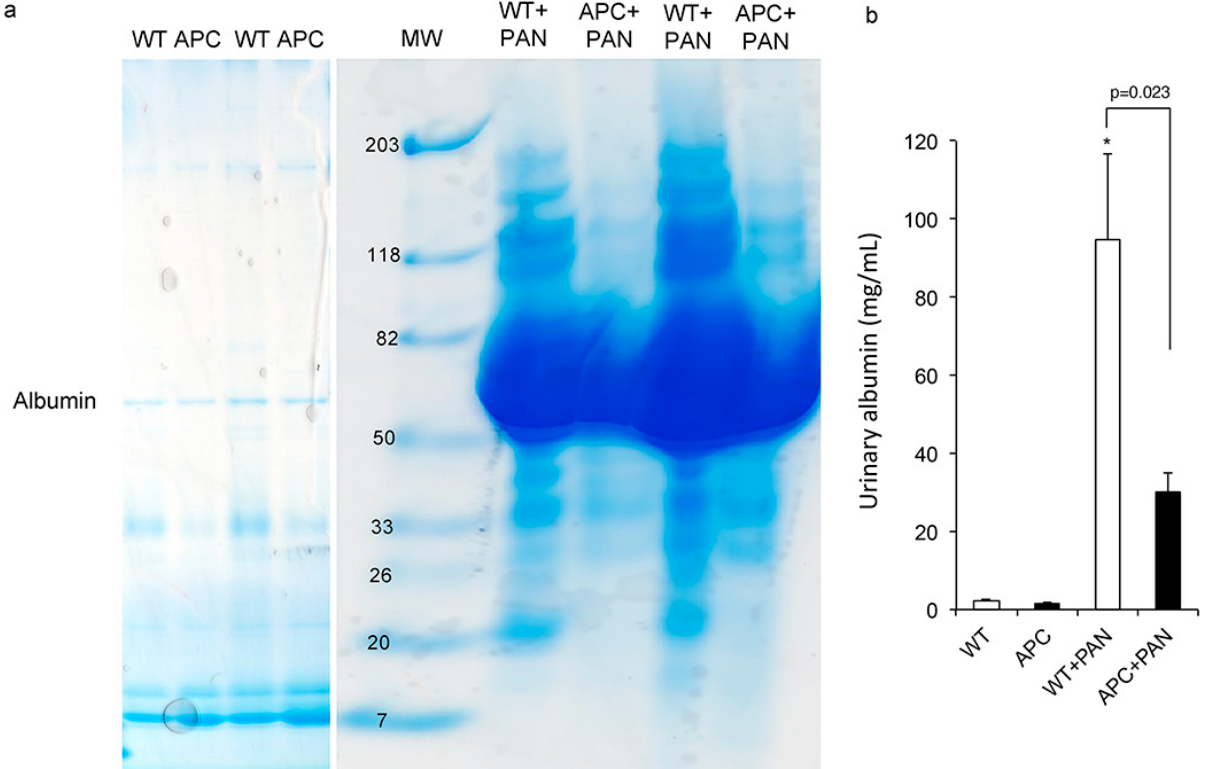
Figure 8. SDS-PAGE analysis of urinary protein ( a ) and densitometry for urinary albumin ( b ) of the wild-type mice (WT), APC1638T mice (APC), and their PAN-induced nephrotic syndrome (WT+PAN, APC+PAN). n = 3 measurements from 2 mice in WT and APC, n = 4 measurements from 3 mice in WT+PAN and APC+PAN. * p = 0.0034 vs. WT.